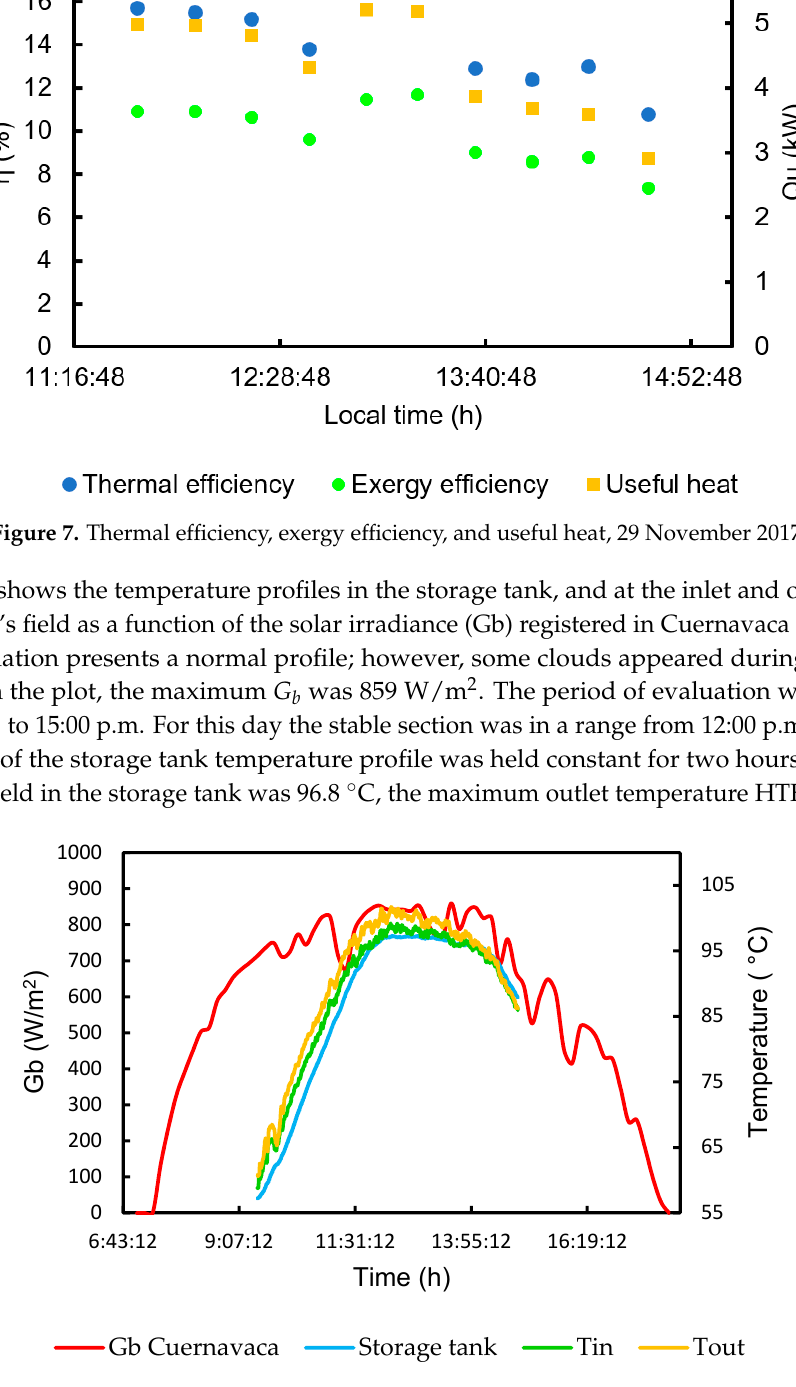
Figure 8. Behavior G b and outlet, inlet and storage tank temperatures, 5 December 2017.